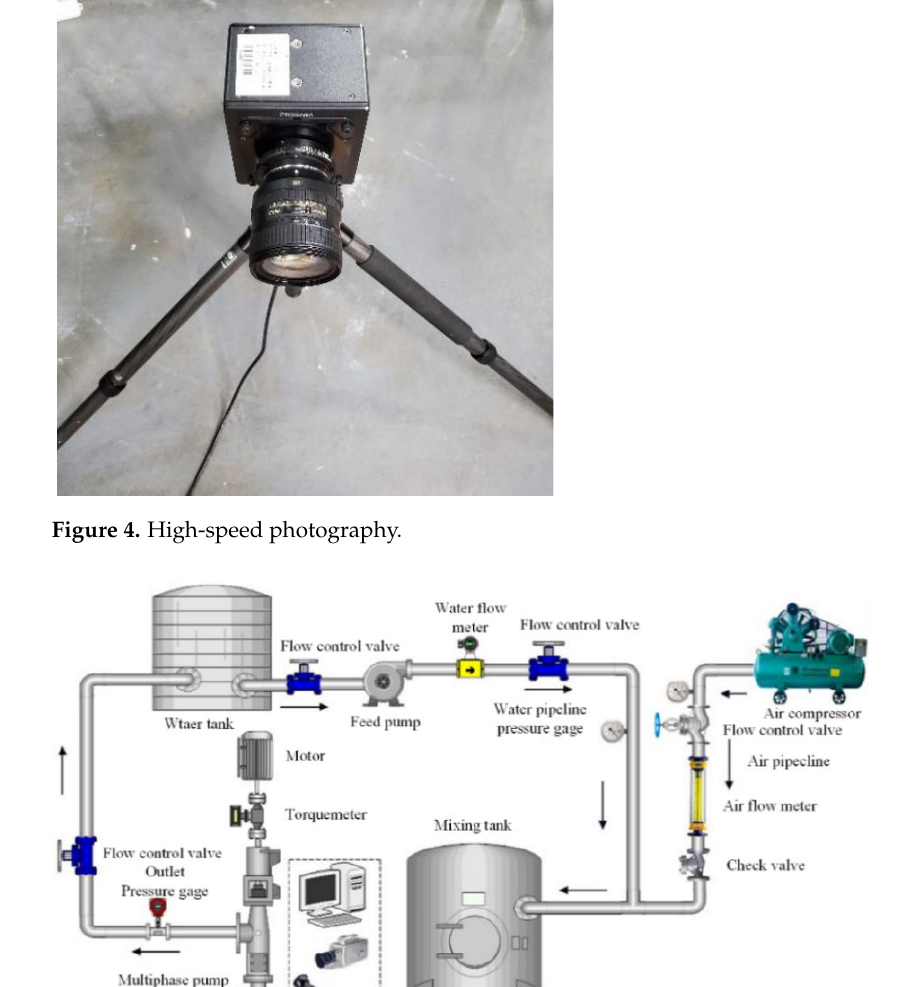
Figure 3. Multiphase test system.